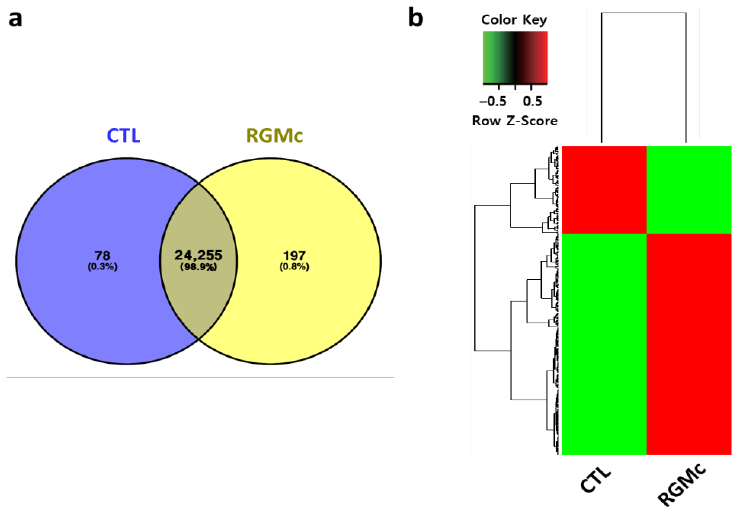
Figure 4. Whole-transcriptome NGS of RGMc-treated ovaries. ( a ) Venn diagram of up/downregulated genes (fold-change > 4) in control and RGMc-treated ovaries. A total of 24,255 genes were included